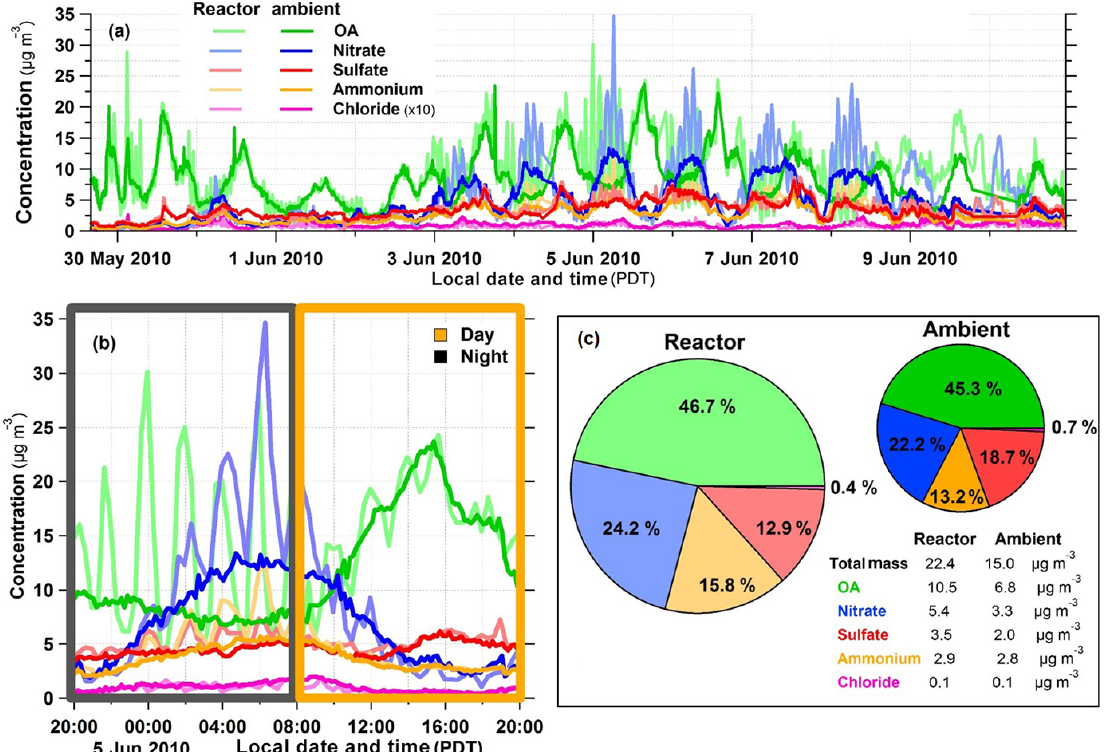
Figure 3. (a) Time series of reactor and ambient species mass concentrations during the sampling period. (b) Zoom on the time series of the species mass concentrations for 1 representative day. Daytime and nighttime are marked. (c) Average fraction contribution from organic, nitrate, sulfate, ammonium, and chloride to total AMS aerosol measurements for ambient and reactor (excluding dark reactor, “lights off” periods, i.e., periods are included only if OH exp > ambient). The pie chart areas are proportional to the total mass